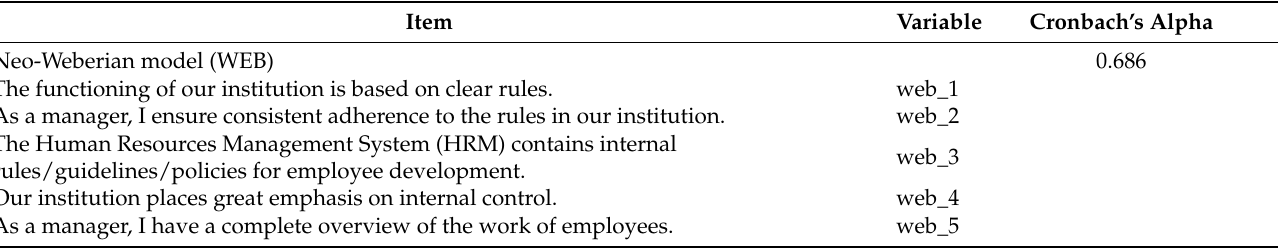
Table A1. Items used in the measurement of public governance